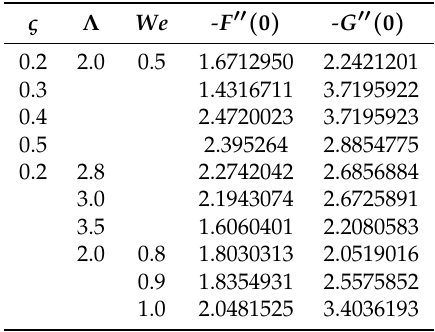
Table 2. Different values of − F (cid:48)(cid:48) ( 0 ) and − G (cid:48)(cid:48) ( 0 ) for varying ς , Λ , and We . ς Λ